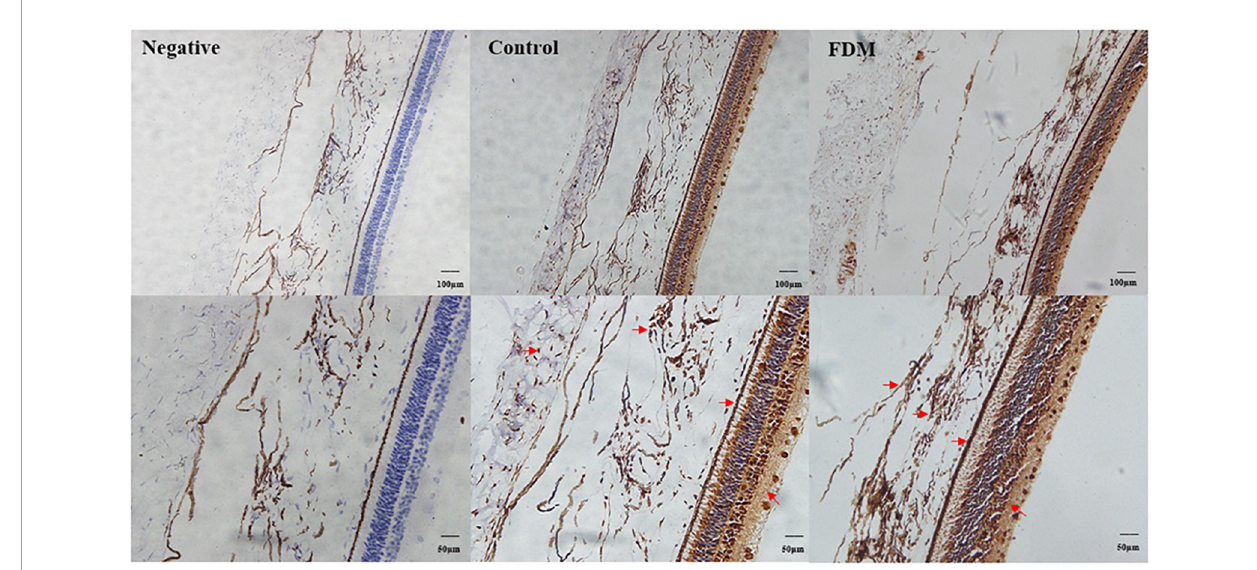
FIGURE9 Immunohistochemical staining of EFEMP1. A brown stain (red arrow) represents the location of EFEMP1 and a blue stain represents the nucleus.